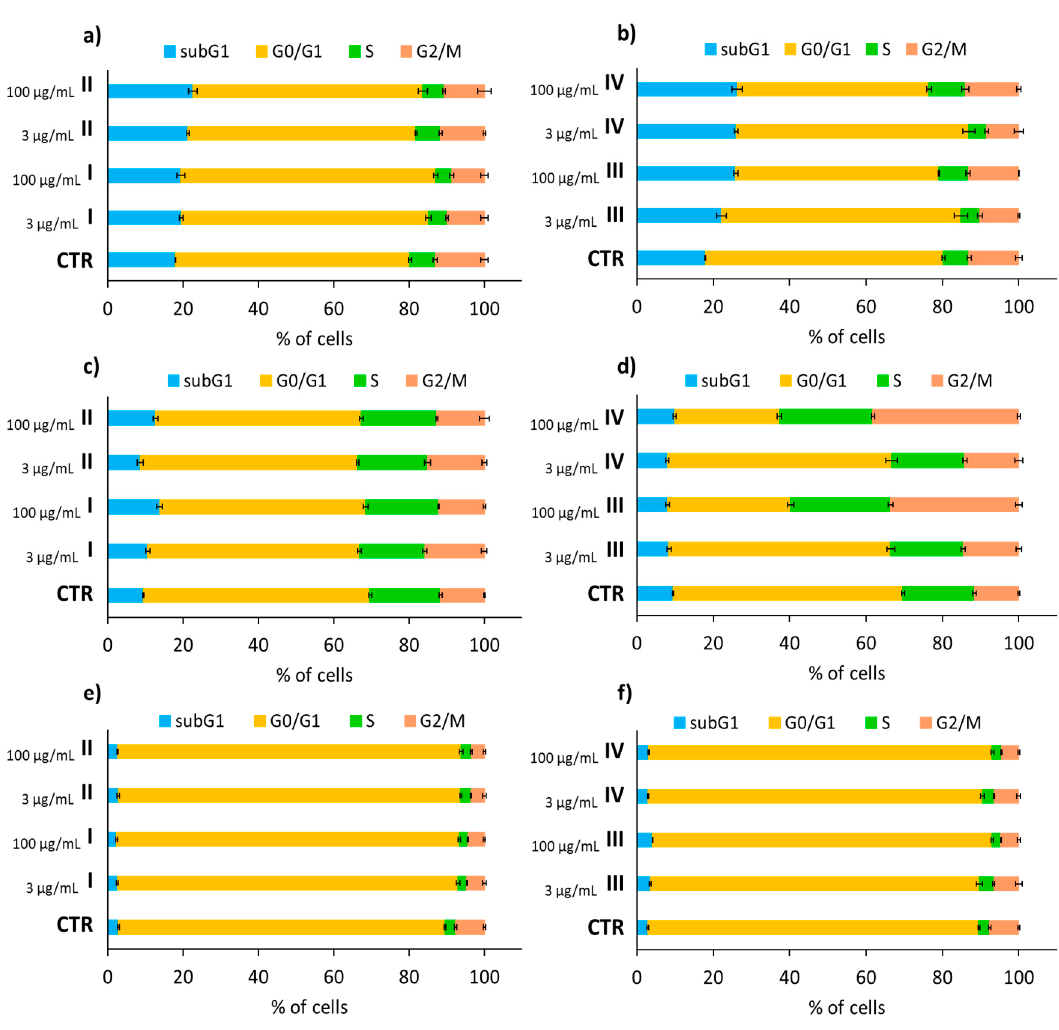
Figure 7. NHDF ( a , b ), HaCaT ( c , d ), and Me45 ( e , f ) cell cycles after carrier solution application at concentrations of 3 μ g/mL or 100 μ g/mL, followed by a 72 h incubation and compared to untreated control cells (CTR), where subG1—dead cells, G0/G1—mononuclear cells, S—DNA replication, G2/M—mitosis. Means ± S.D. from three independent experiments.